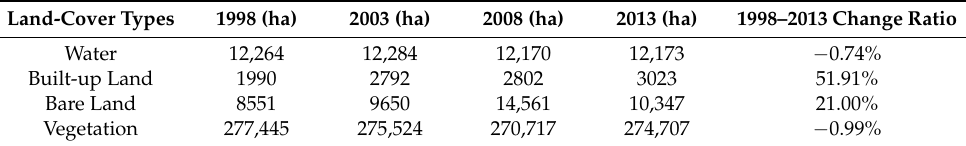
Table 2. Changes in land-cover areas against time on basin